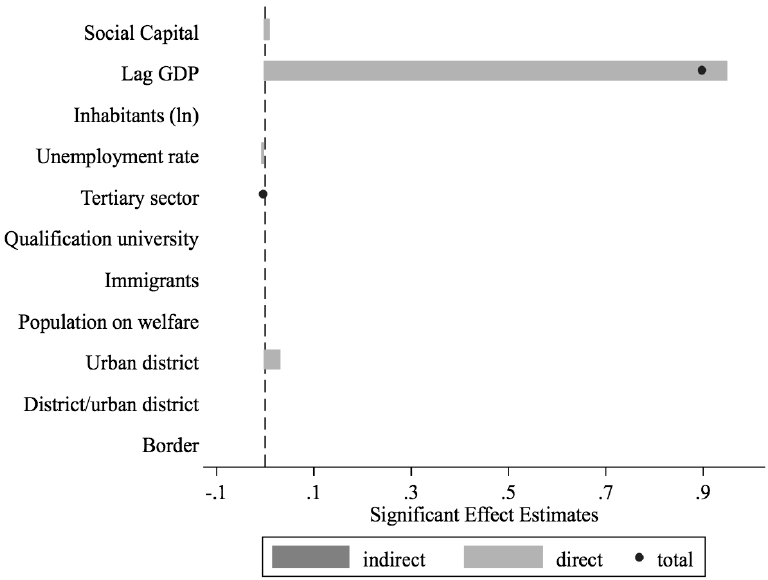
Figure A.2: Illustrating significant effects estimates of the SDM from Table A.2 (direct and indirect effects)